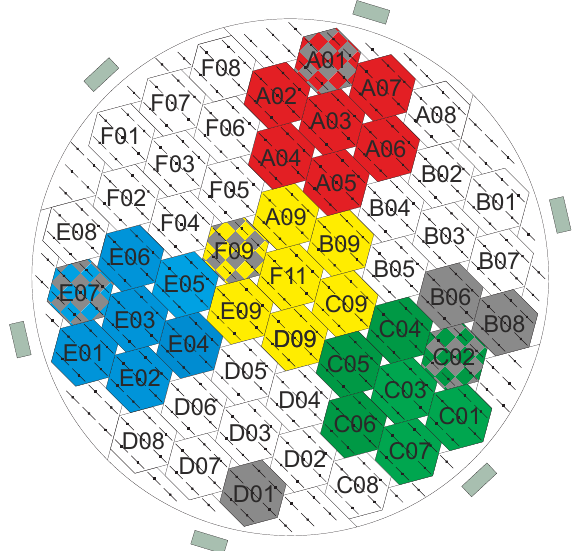
Figure 1. Sketch of MAARSY’s main antenna array, consisting of 433 yagi antennae. The anemone subarray groups A, C, E and M, each composed of 49 antennae, are individually colour coded, while 7 antennae form a hexagon, e.g. D-01. Besides the total antenna array, the subarray groups marked in grey are used for reception in the examined experiment